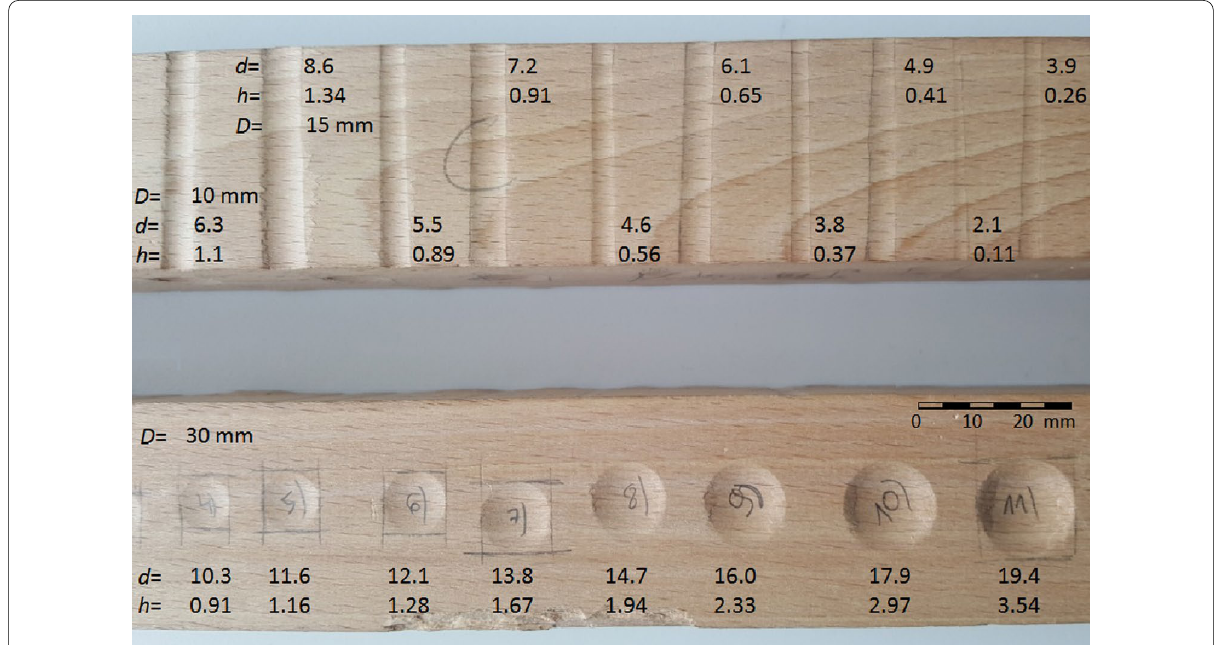
Fig. 12 Photos of indentations in beech wood. At the top, sample C with part of the alternating indentations of D cylindrical indenters. At the bottom, sample D with indentations from the D calculated depth h are